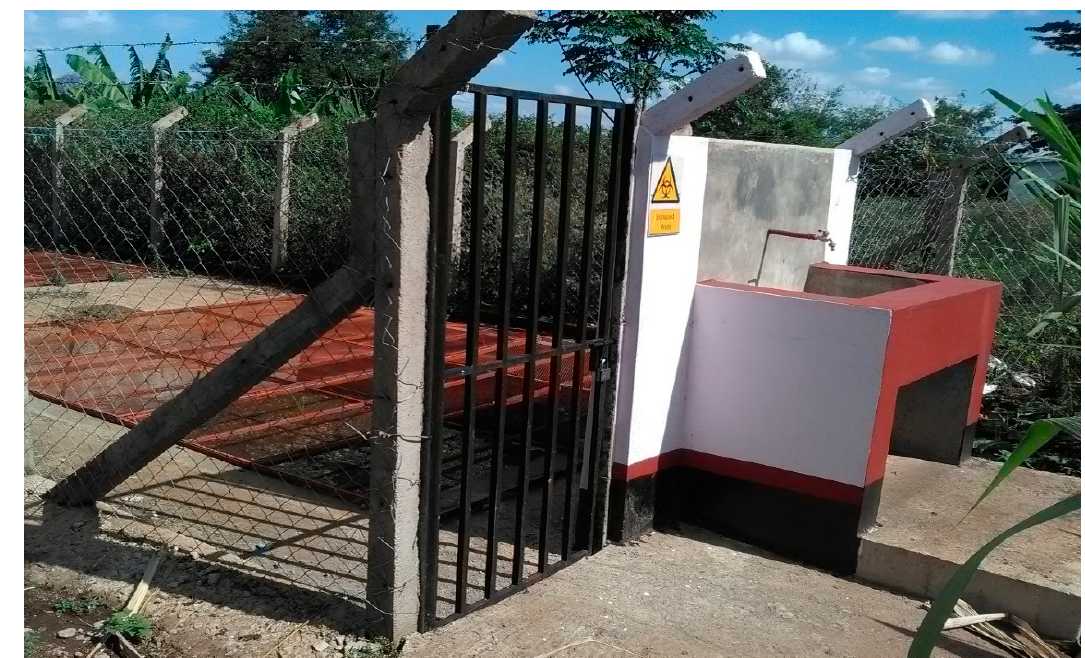
Figure 5. A picture of constructed waste pit at KCMUCo ‐ PAMVERC, Tanzania.